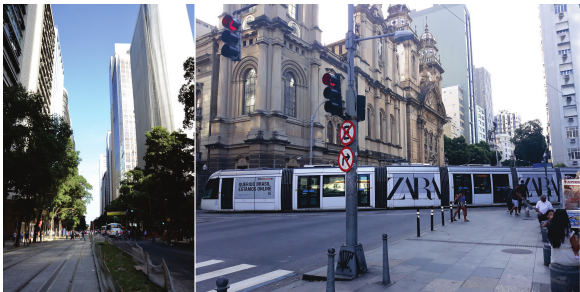
Figure 3: Architecture and road system at Rio city center. Left: Rio Branco Av. shared road by pedestrians, VLT and cars. Right: VLT and histocial buildings